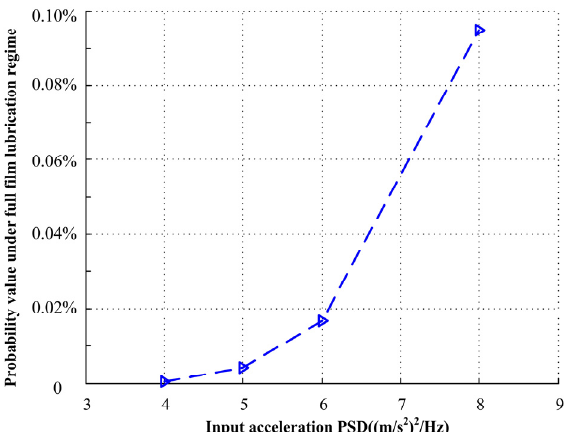
Figure 8. Probability density of closing force F cl under different input acceleration PSDs and the relationship with duty parameter G.